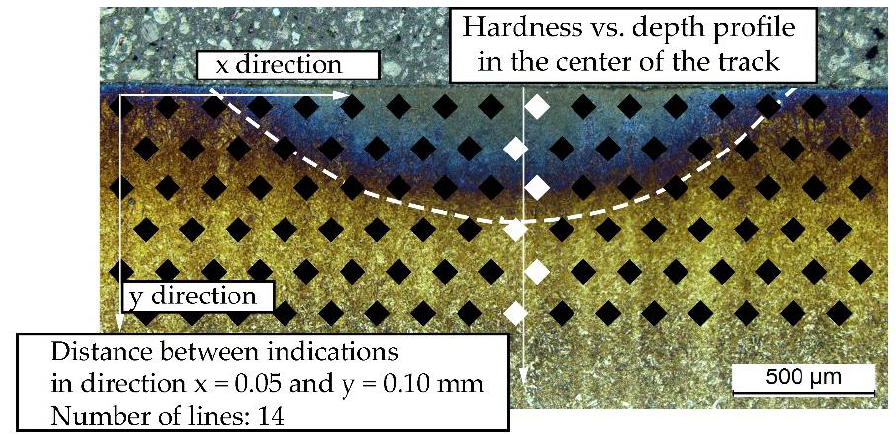
Figure 3. Scheme of the hardness measurement locations on the cross-section of the track. Microstructure examination of samples was performed using a Leica DMI 3000M metallographic microscope (Leica Microsystems, Wetzlar, Germany). Ground and polished samples were subjected to chemical etching with nital reagent (HNO 3 –4 cm 3 and ethanol 96%–100 cm 3 ) to reveal microstructure morphology and the extent of the heat-affected zone created by laser